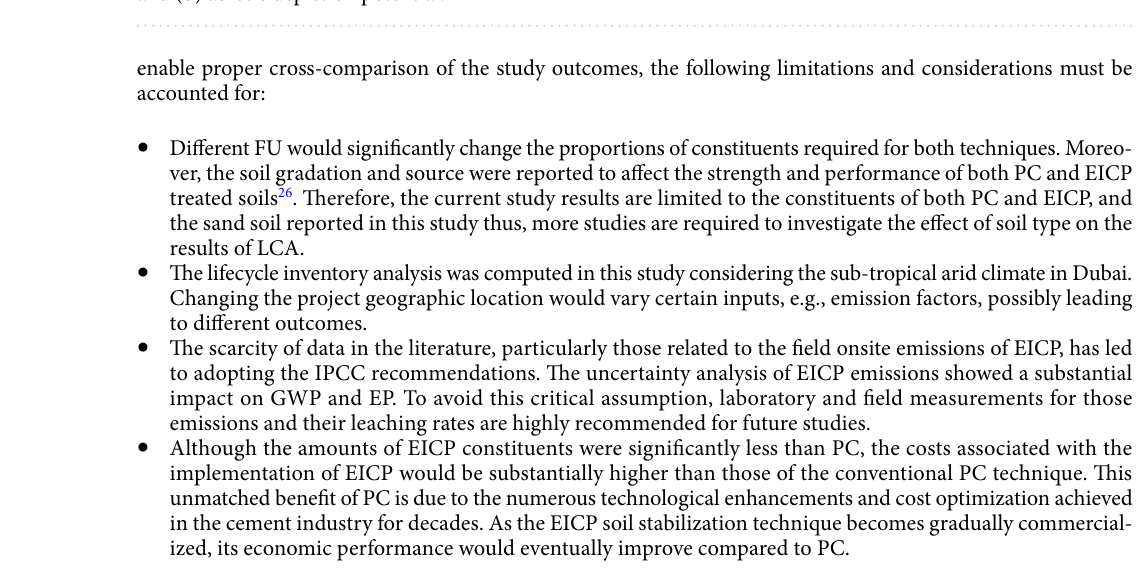
Figure 8. Sensitivity analysis scenarios of EICP compared to PC and MICP for: ( a ) global warming potential, and ( b ) abiotic depletion